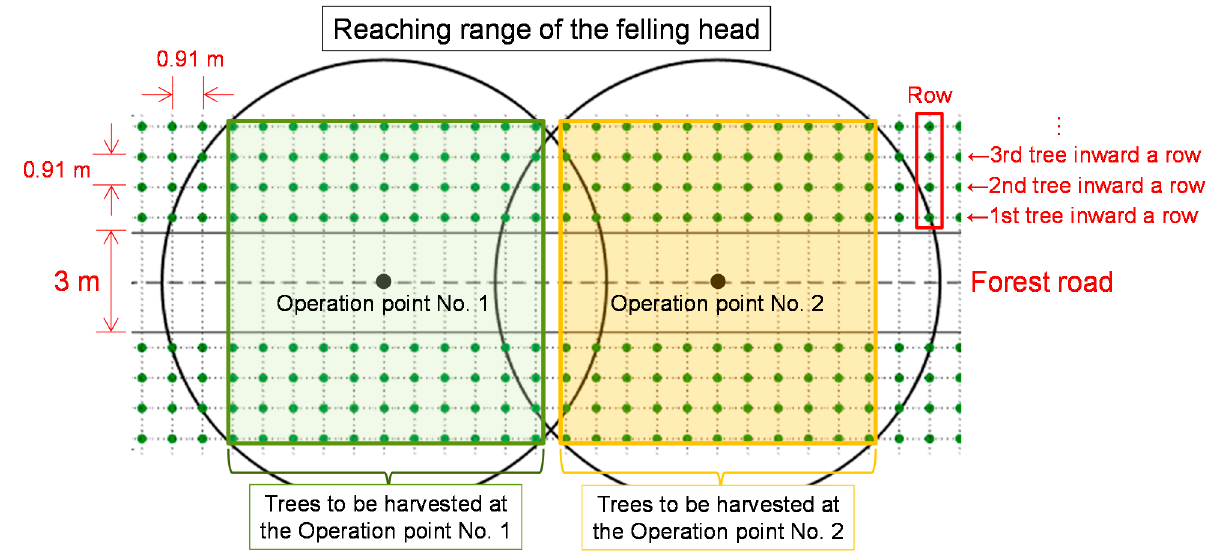
Figure 1. Assumed simplified model forest.